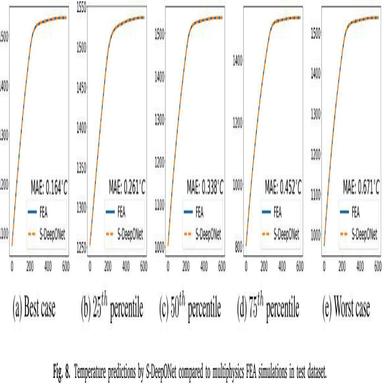
Stress predictions by S-DeepONet compared to multiphysics FEA simulations in test dataset.